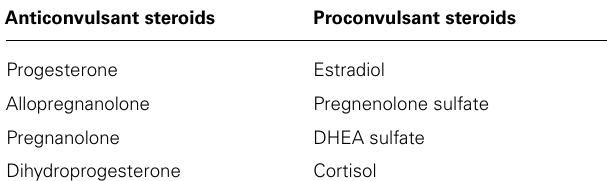
Table 2 | List of steroid hormones and neurosteroids that affect seizure